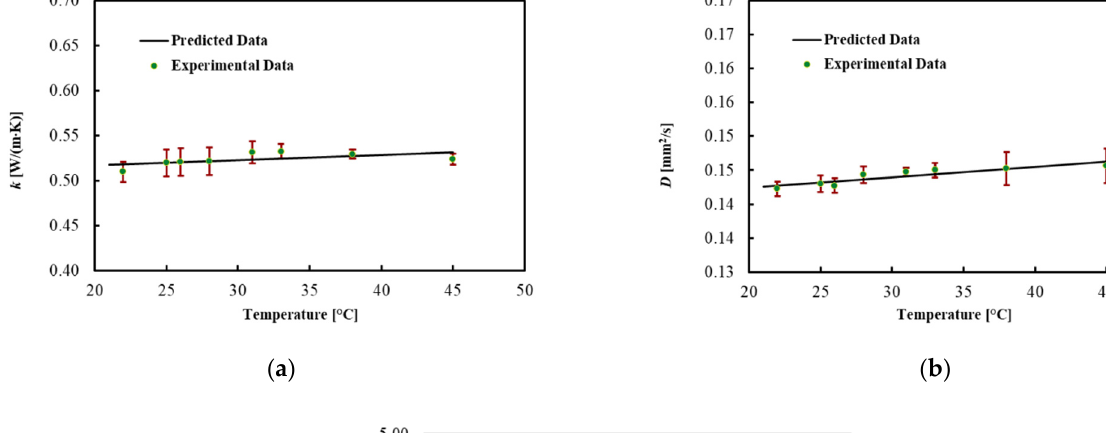
10 of 16 Table 4. Regression coefficients, R 2 and mean percentage error (MPE) of the model for brain tissue. Thermal Property